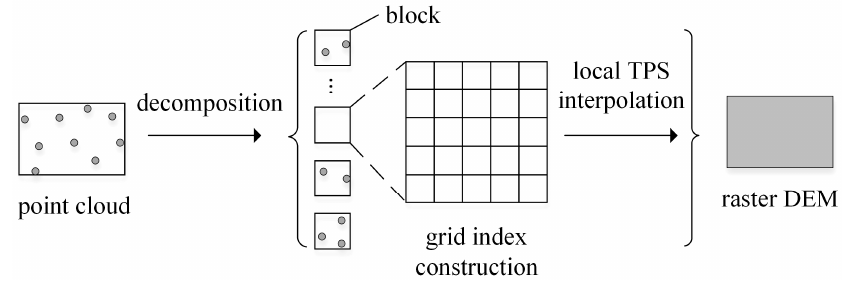
Figure 2. Main steps of using local Thin Plate Spline (TPS) interpolation for LiDAR point clouds.